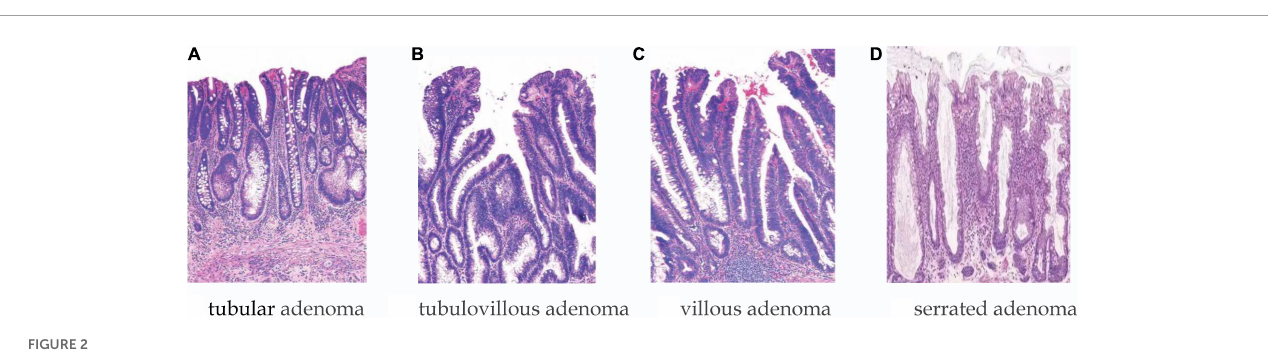
FIGURE1 Flowchart of the patients included in the study.